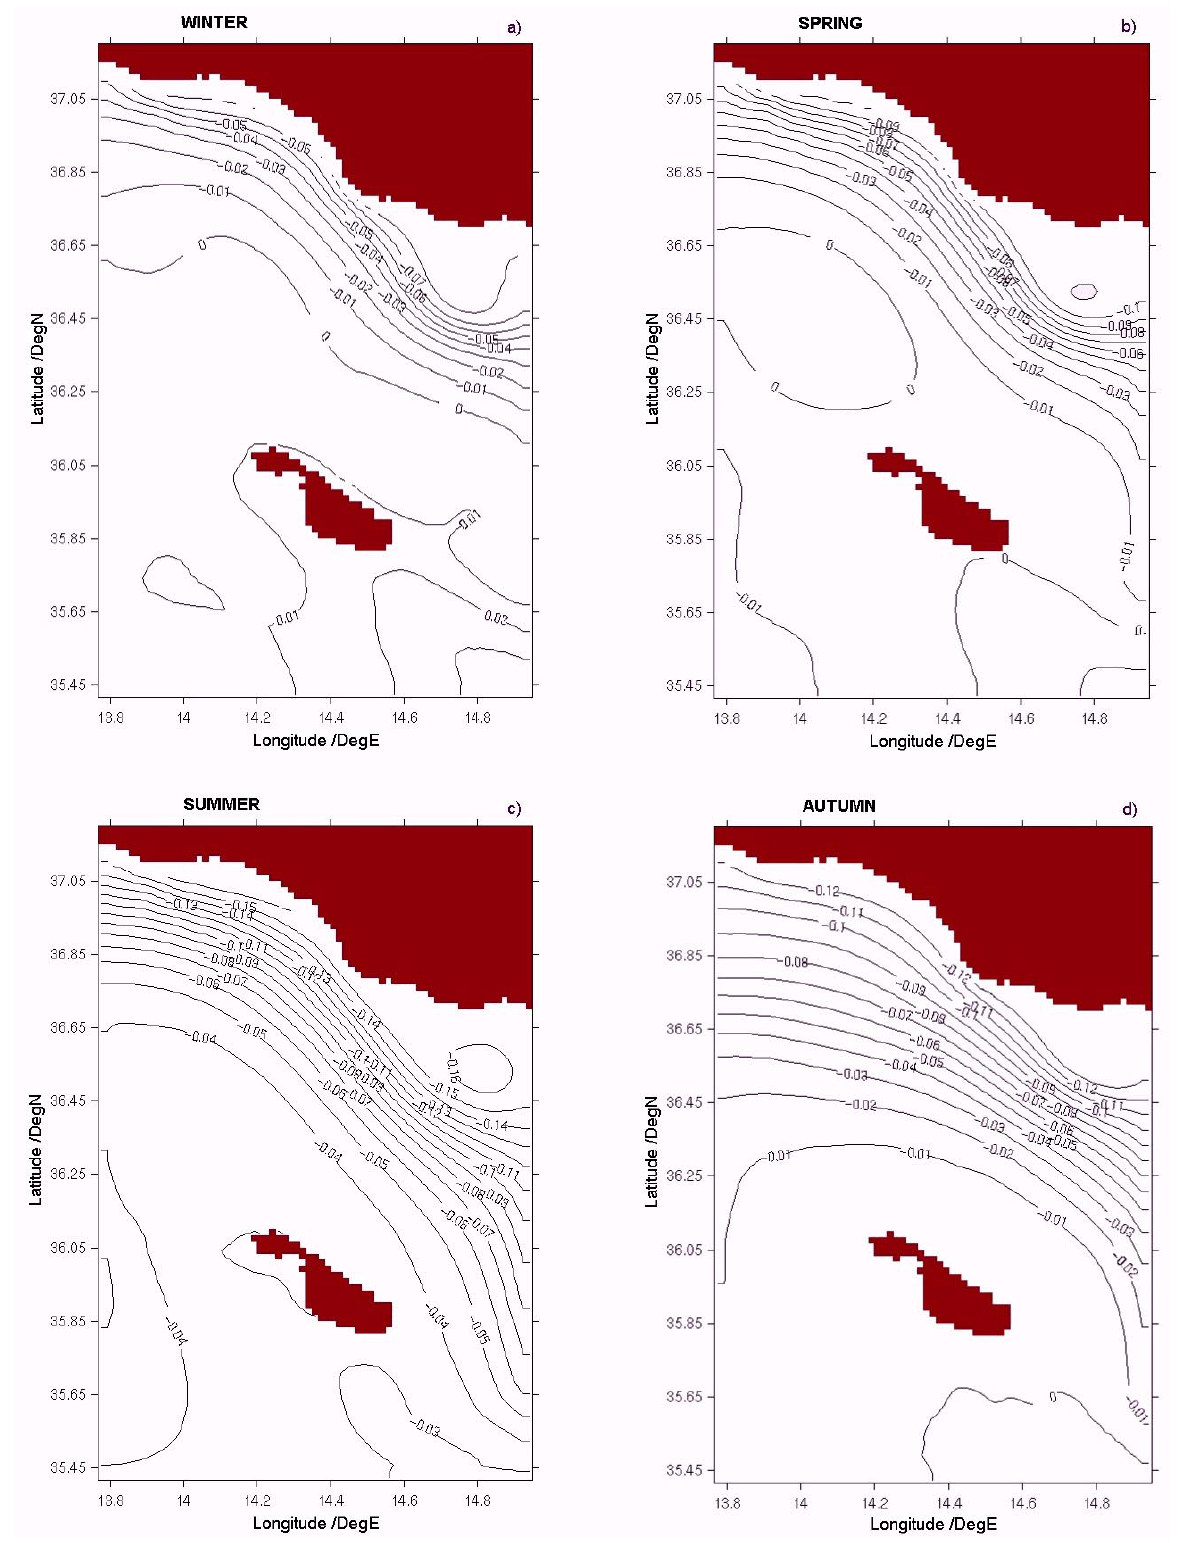
Fig. 11. Mean seasonal free surface elevation field in the model domain for (a) winter, (b) spring, (c) summer and (d)